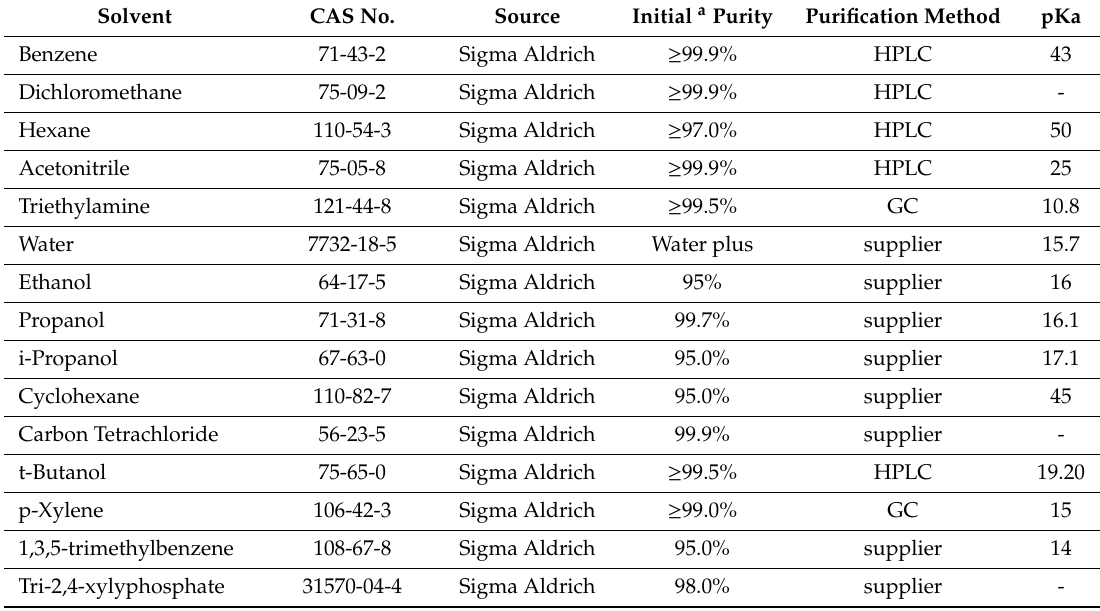
Table 1. Characteristics of the liquids used in the determination of the enthalpy